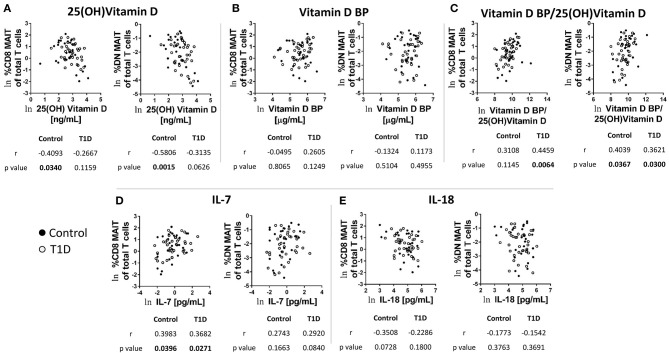
Correlations between CD8 and DN MAIT cell frequencies and select soluble factors in plasma. (A) Correlation between CD8 and DN MAIT cells frequency and 25 (OH) vitamin D (B) Correlation between CD8 and DN MAIT cells frequency and vitamin D binding protein (BP). (C) Correlation between CD8 and DN MAIT cells frequency and ratio of vitamin D BP to 25 (OH) vitamin D. (D) Correlation between CD8 and DN MAIT cells frequency and IL-7. (E) Correlation between CD8 and DN MAIT cells frequency and IL-18. For (A–E), ln denotes that values were transformed using natural logarithm. Since these relationships (A–E) were more-or-less directionally similar, we also examined them by pooling the control and T1D subjects. These results can be viewed in Supplementary Figure 4.